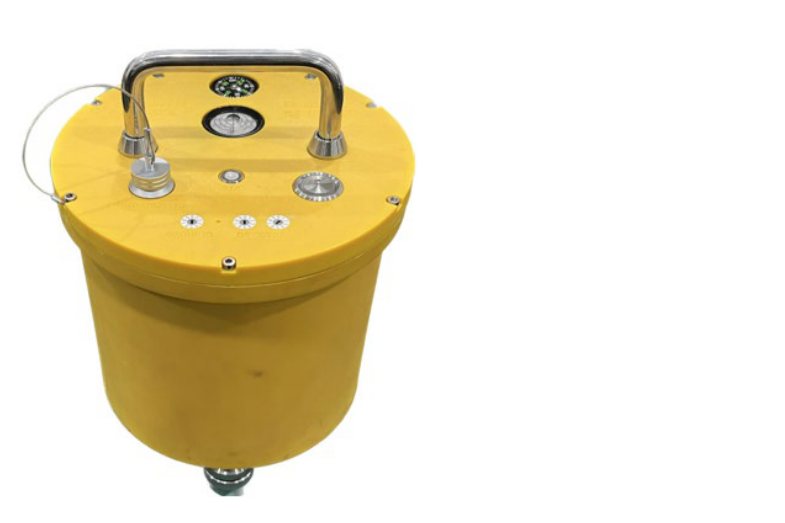
Figure 6. VIDO intelligent micromotion detector. Table 1. The main performance indicators of VIDO micromotion detector. Table 1. The main performance indicators of VIDO micromotion detector.